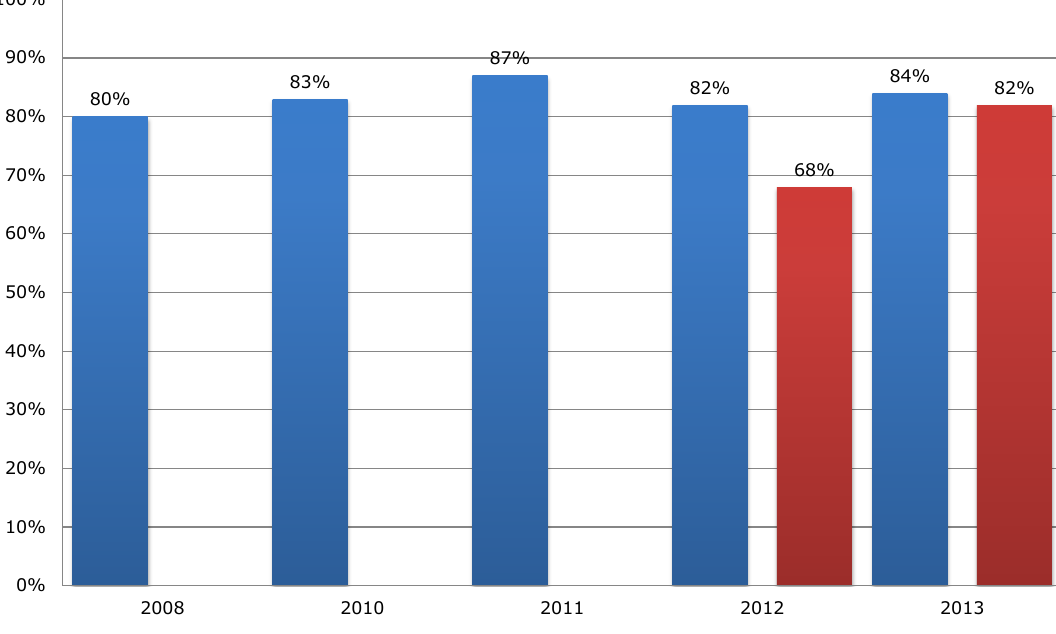
Figure 6: Yearly comparison of levels of awareness of ability to switch supplier, or tariff or payment method with current